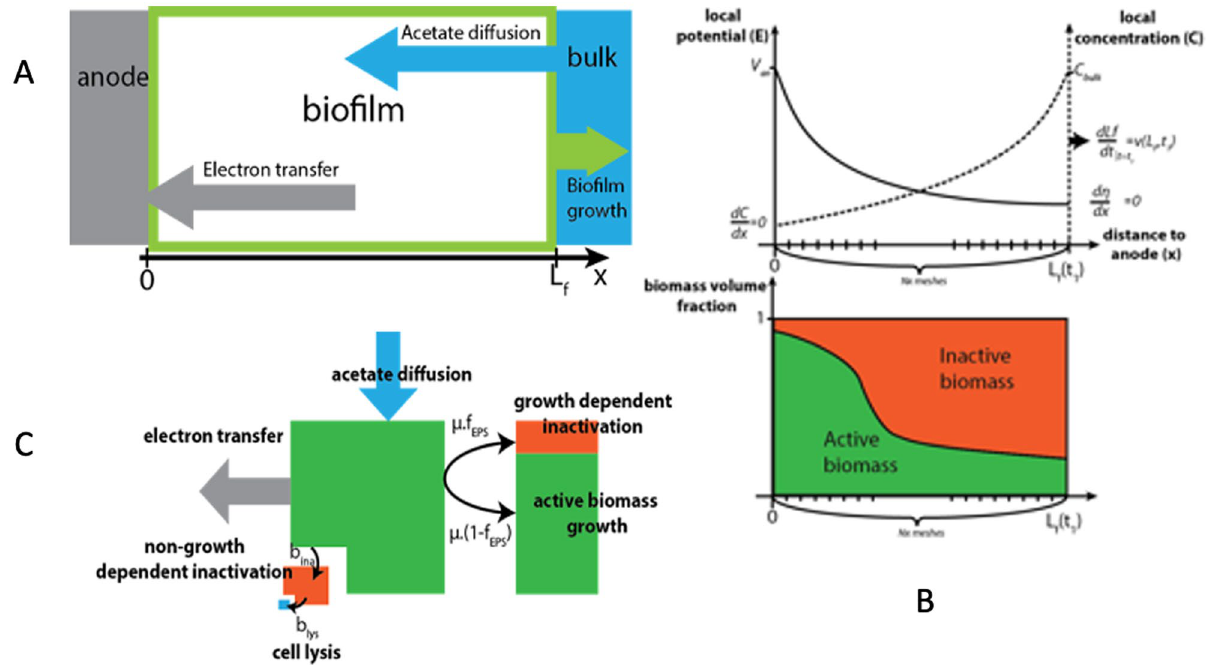
Figure 1. Schematic representations of model structure and concepts. ( A ) schematic 1D model representation; ( B ) schematic biomass evolution representation; ( C ) Boundaries conditions and profiles for biomass acetate concentration, local potential and volume biomass